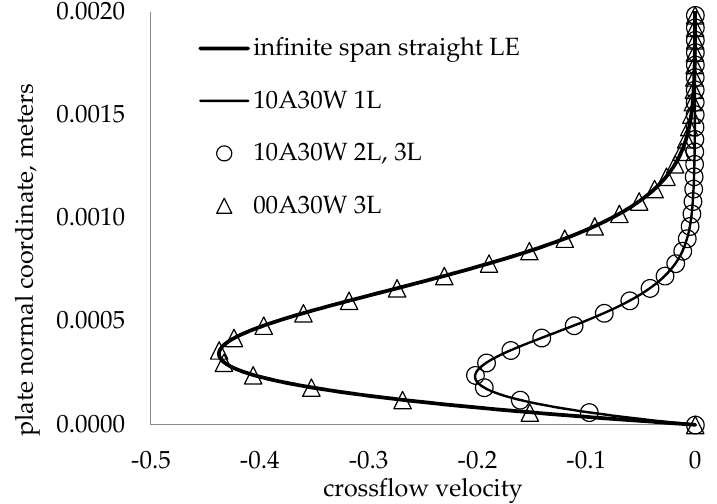
Figure 6. Crossflow velocity profiles for straight LE and 10A30W LE at di ff erent span locations, Figure 6 . Crossflow velocity profiles for straight LE and 10A30W LE at different span locations, at at 20% chord. 20% chord. Table 1. Eigenvalues for Blasius flow at R = 580 and α = 0.179.